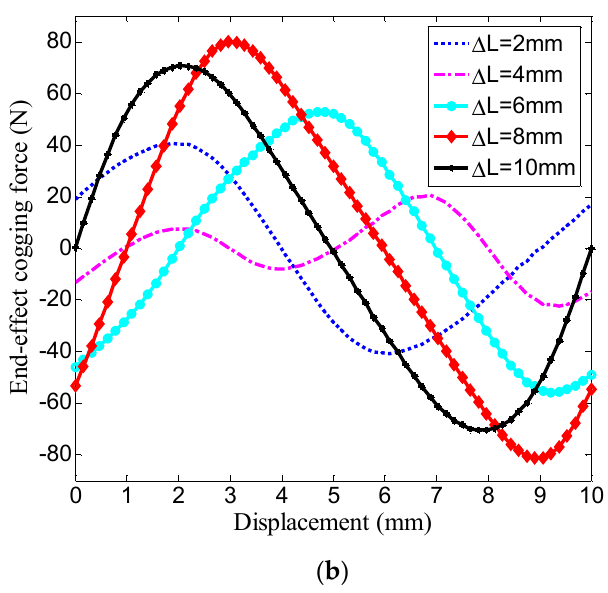
Figure 5. End-effect cogging force vs. mover displacement and Δ L . ( a ) 3-D view; ( b ) 2-D view.